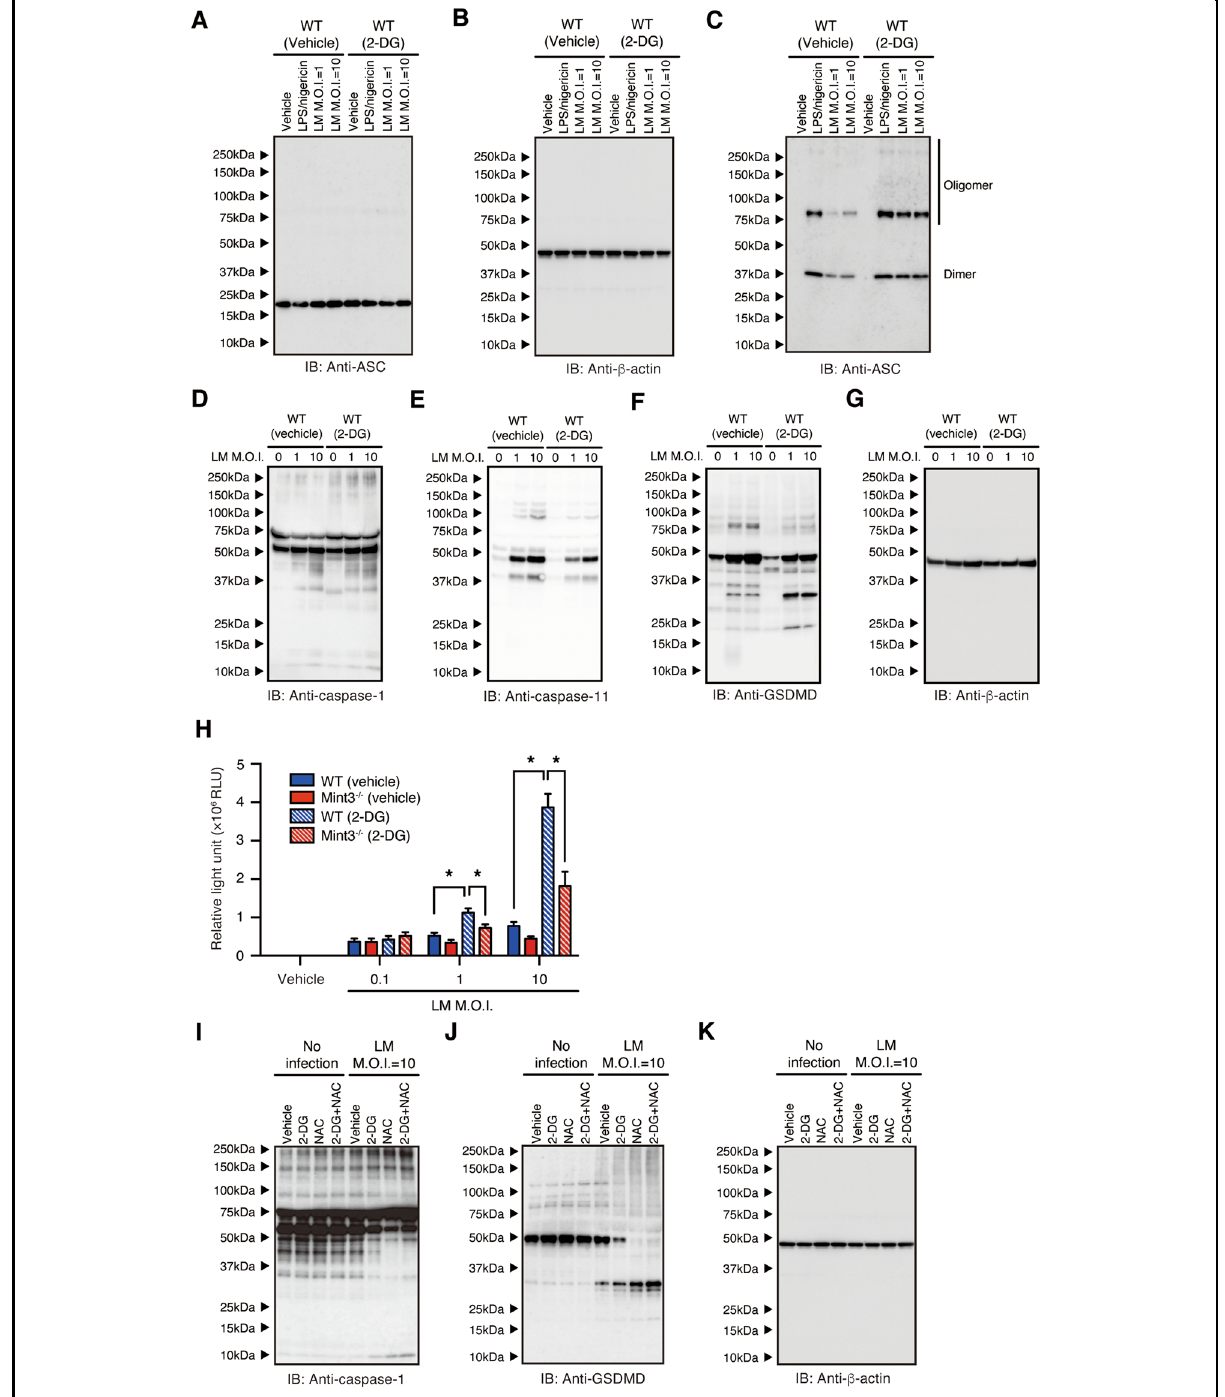
Fig. 6 Mint3-mediated glycolysis and ROS production control in fl ammasome activation in LM-infected macrophages. A – C Immunoblot analysis of the A total cell lysate or C disuccinimidyl-suberate-treated Triton-insoluble fractions in LM-infected WT BMMFs treated with vehicle or 2- DG. B The expression of β -actin in the total cell lysate was used as a loading control. D – G In fl ammasome activation in 2-DG-treated WT or Mint3 – / – BMMFs, which were infected in vitro with LM (MOI = 1 or 10). D Caspase-1, E caspase-11, or F GSDMD expression was measured in the total cell lysates of LM-infected WT BMMFs treated with vehicle or 2-DG. G Expression of β -actin was used as a loading control. H ROS production in 2-DG- treated WT or Mint3 – / – BMMFs. Production of ROS was measured via luminometry 8 h after LM infection. Data are presented as the means ± SDs of triplicates. Data are representative of two independent experiments. * P < 0.05 by the Student ’ s t -test. I – K In fl ammasome activation in LM-infected WT BMMFs treated with vehicle, 2-DG, N -acetyl- L -cystine (NAC), or 2-DG + NAC. I Caspase-1 and J GSDMD expression was measured in the total cell lysates of LM-infected WT BMMFs treated with vehicle or 2-DG. K Expression of β -actin was used as a loading